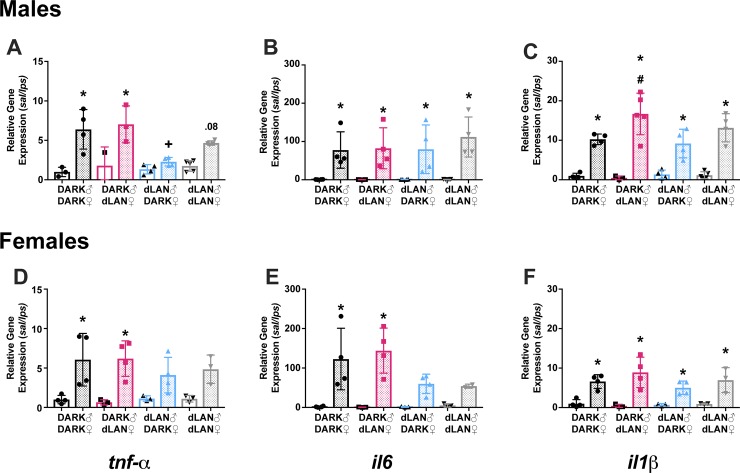
Preconception dLAN altered splenic cytokine gene expression in an offspring sex-specific manner.Splenic tnf-α, il-6, and il-1 expression 3 hours post-LPS challenge in males (A-C) and females (D-F). Open bars represent saline, dotter bars represent LPS. N = 3-5/group/sex; error bars represent SD. #, P < 0.05 Dark-dLAN LPS vs Dark-Dark LPS and dLAN-Dark LPS; +, P < 0.05 dLAN-Dark LPS vs Dark-Dark LPS and Dark-dLAN LPS; *, P < 0.05 saline vs LPS.